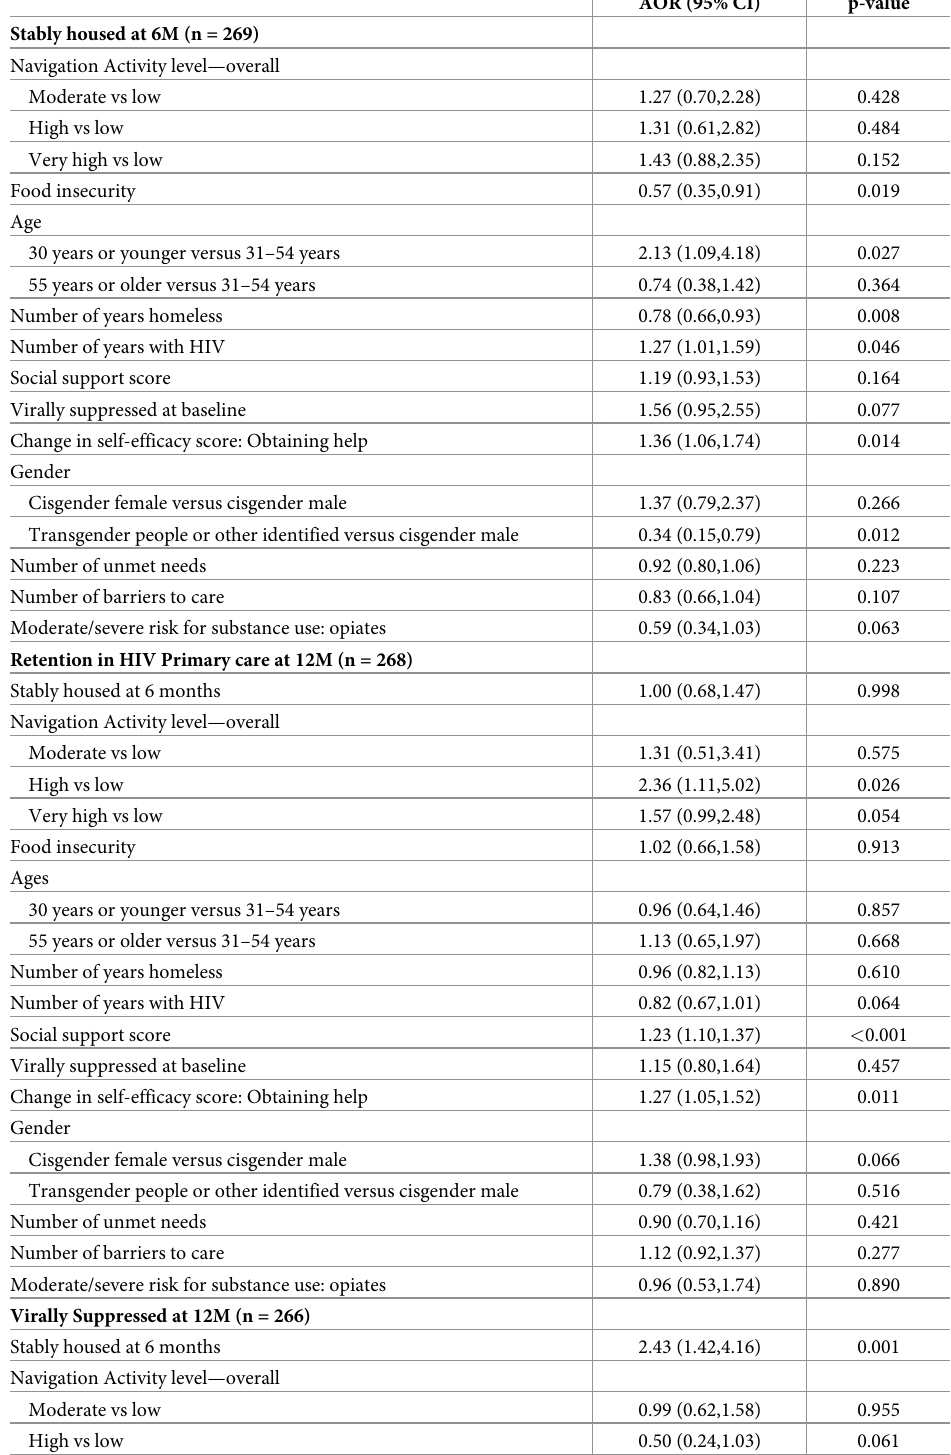
Table 3. Path model logistic regression results for participant characteristics and navigation activity level with housing stability and HIV health outcomes, HRSA/SPNS Building a Medical Home for Multiply diagnosed HIV homeless populations 9 sites in the US, 2013–2017 (n =